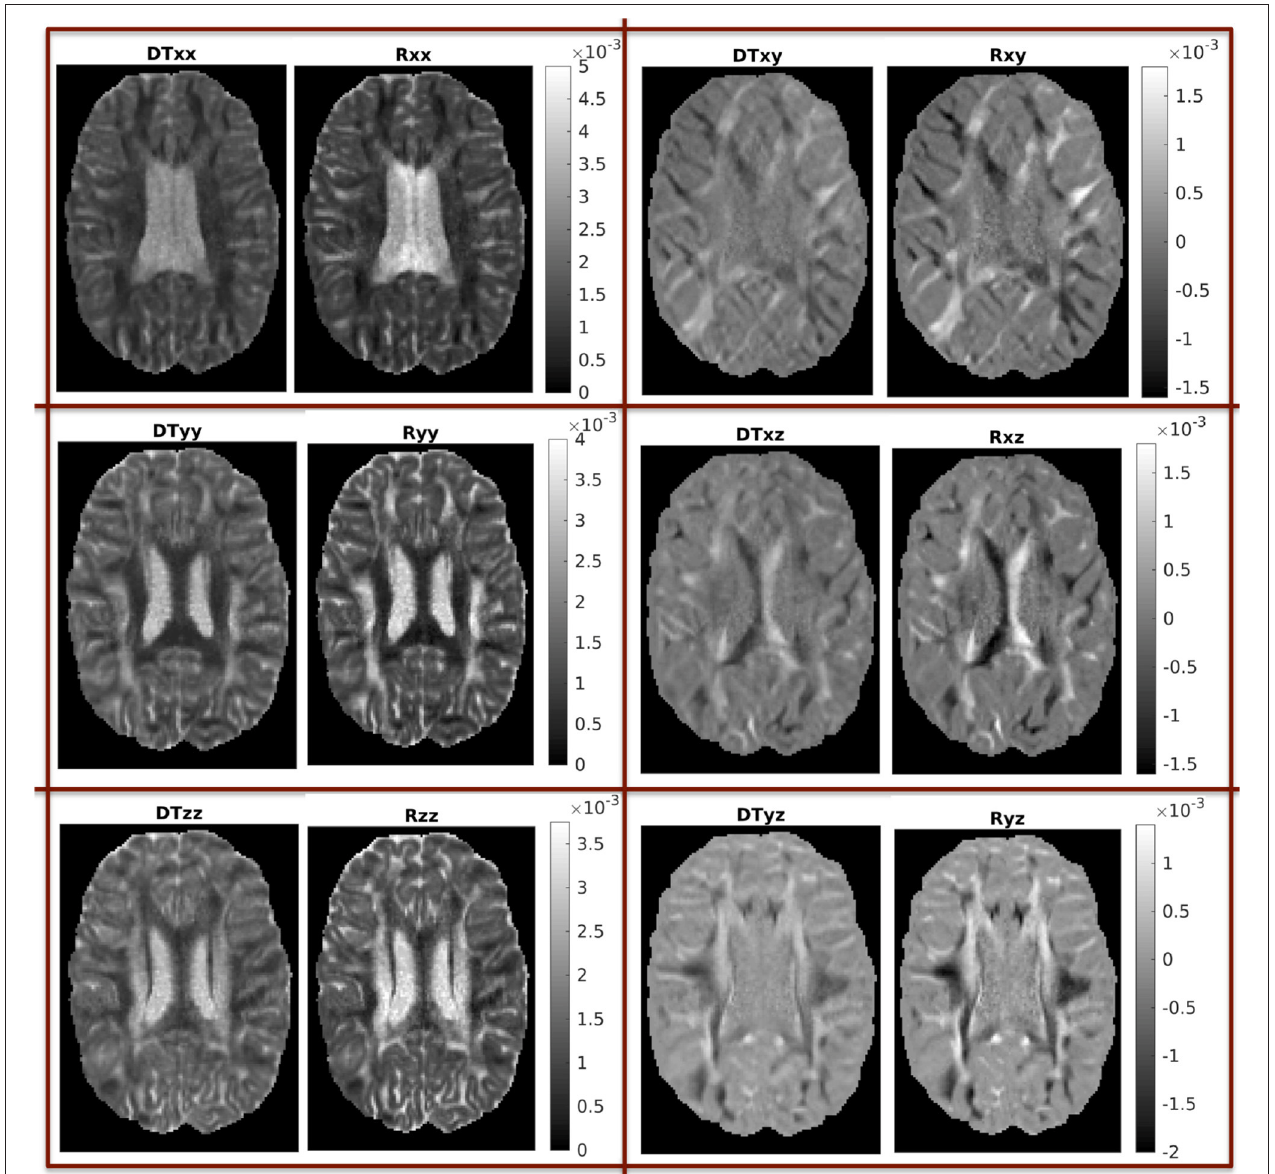
FIGURE 3 | Components of the two tensors for axial slice 70 (units of mm 2 /s). For ease of comparison, corresponding components were plotted in the same intensity scale.